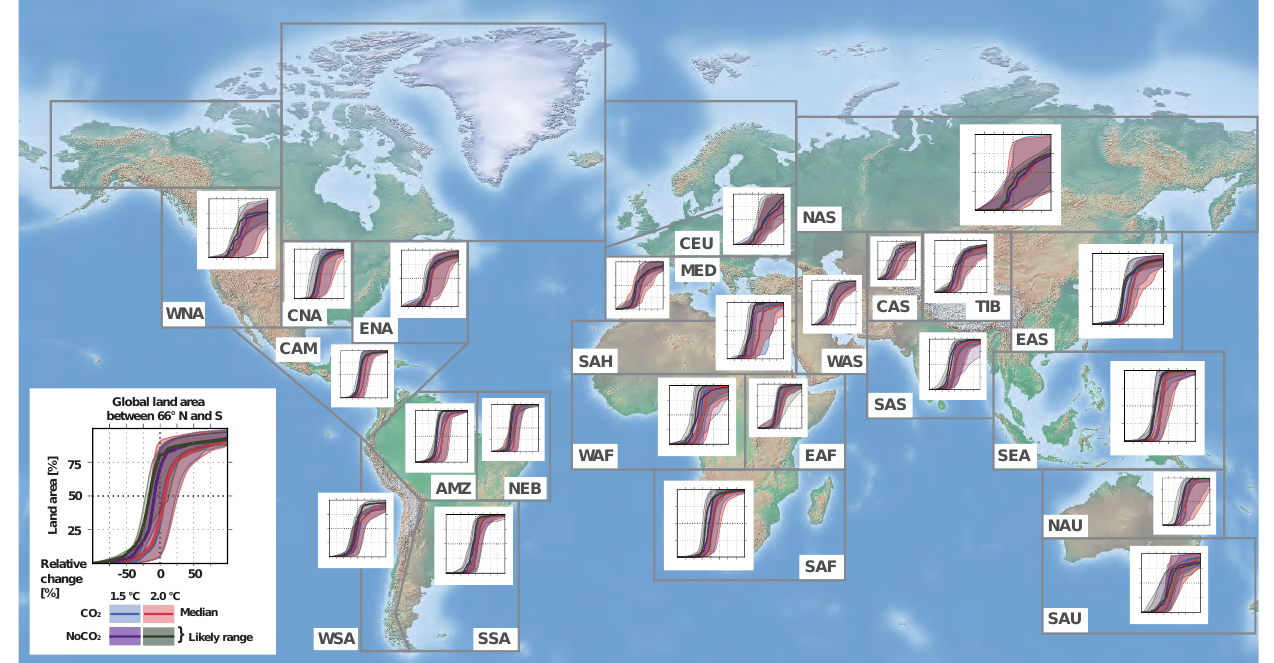
Figure 12. Same as Fig. 9 but for changes in rice yields.